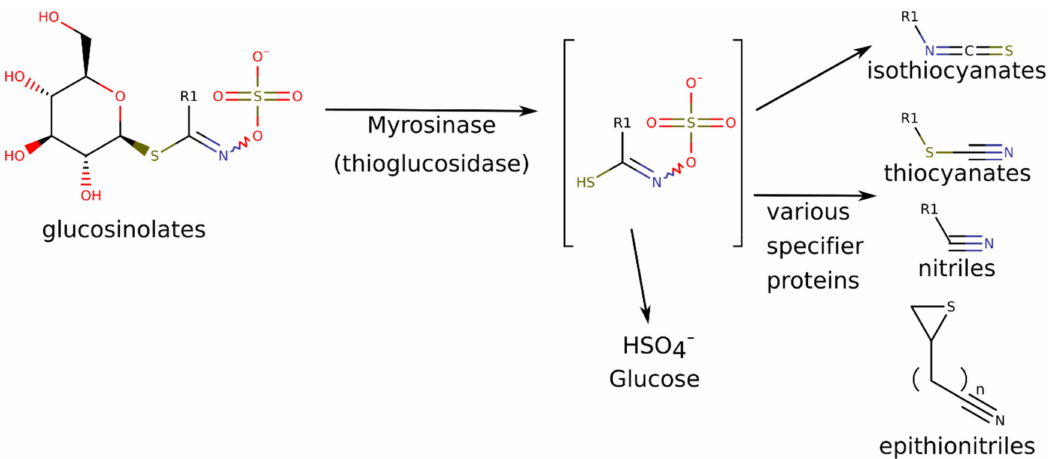
Figure 1. Conversion of glucosinolates into isothiocyanates and other various volatile breakdown products, depending on reaction conditions. Characteristic glucosinolates and breakdown products in horseradish include: R 1 = allyl (glucosinolate: sinigrin, specific decomposition products: allyl isothiocyanate, allyl thiocyanate and allyl nitrile); R 1 = 2-phenylethyl- ( = phenethyl-) (glucosinolate gluconasturtiin, specific decomposition products: 2-phenylethyl-isothiocyanate, 2-phenylethyl-thiocyanate and 3-phenylpropionitrile)